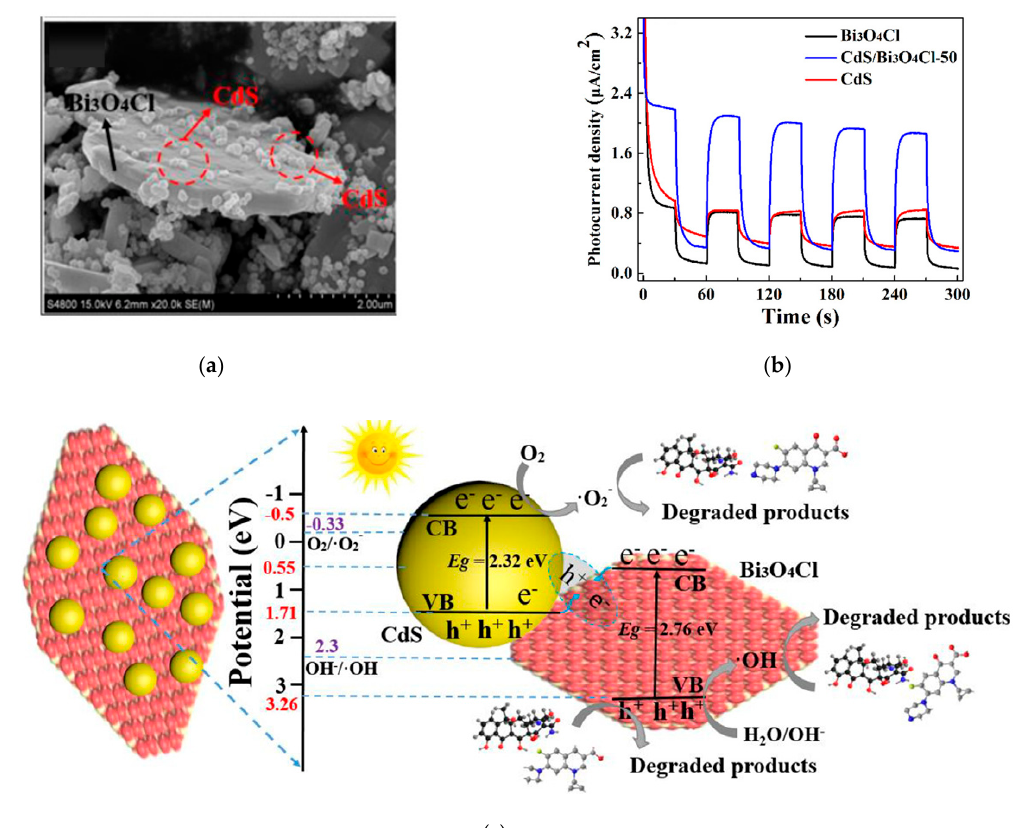
Figure 3. ( a ) Scanning electron microscope (SEM) image of CdS/Bi 3 O 4 Cl-50 heterostructure; ( b ) the transient photocurrent response of the bare CdS, Bi 3 O 4 Cl and Z-Scheme CdS/Bi 3 O 4 Cl-50 heterostructure; ( c ) possible photocatalytic mechanism of Z-scheme CdS/Bi 3 O 4 Cl photocatalyst for antibiotic treatment under visible light irradiation; CdS/Bi 3 O 4 Cl-50: mass ratio of Bi 3 O 4 Cl to CdS is 50. Reproduced with permission from [75]. Copyright Elsevier, 2018.